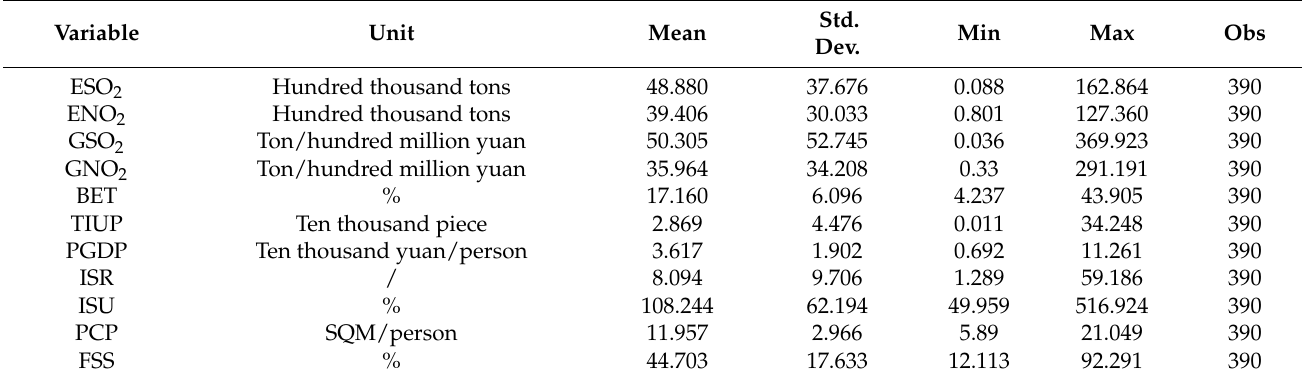
Table 2. Statistical description of